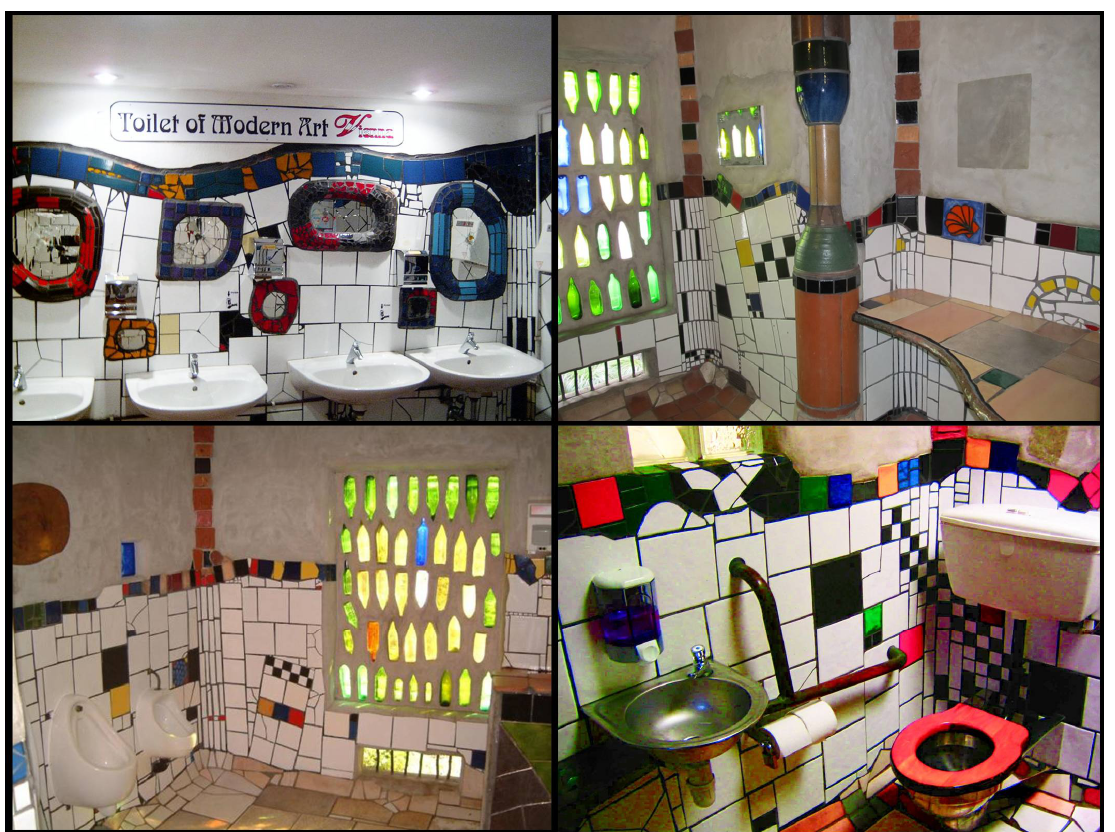
Figure 6. Interiors of the